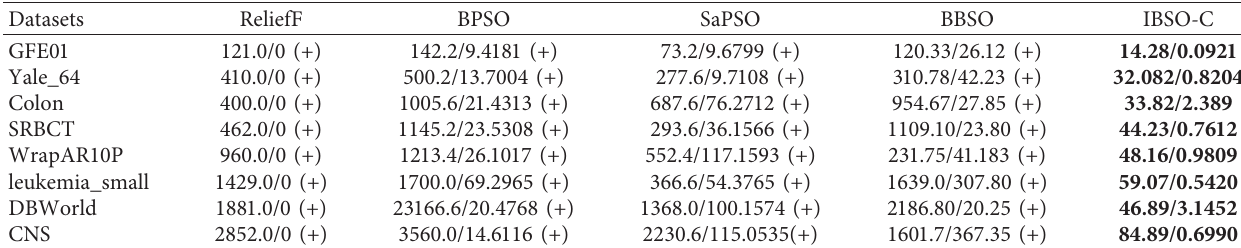
Table 5: FN values obtained by IBSO-C and the four comparison algorithms.